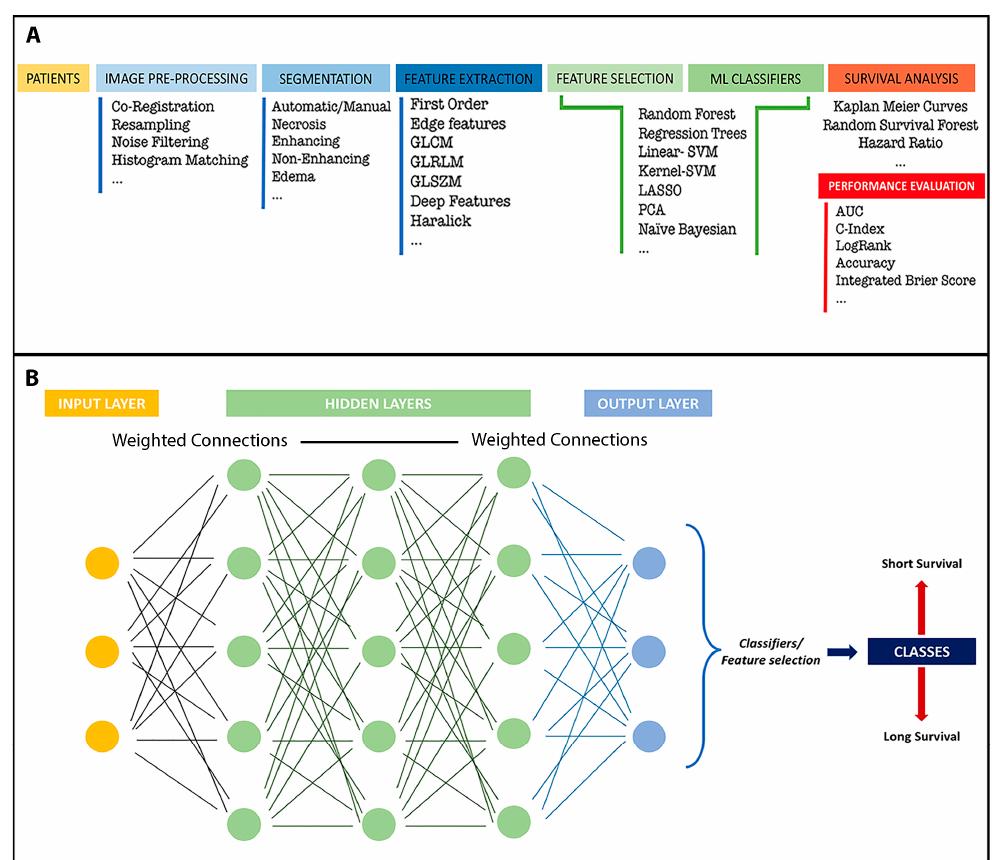
Figure 2. ( A ) Diagram depicting an example of the conventional process for studies implementing radiomics and machine learning algorithms. ( B ) Diagram of an example of a survival prediction investigation based on deep learning.